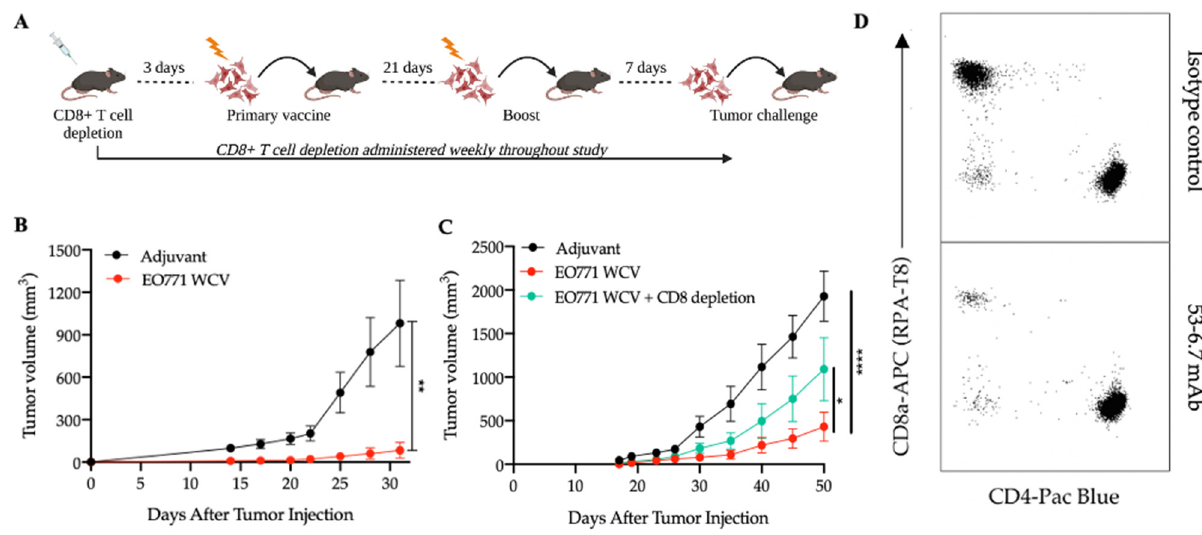
Figure 1. CD8 + T cells are required for protection against mesenchymal-like EO771 tumor growth using EO771 whole cell vaccine (WCV). ( A ) Overview of tumor studies is shown. ( B ) Tumor growth curve of EO771 cells in mice treated with adjuvant alone ( n = 10) or EO771 WCV ( n = 10). Error bars depict mean with SEM. A two-way ANOVA was performed, and significant protection was provided by the EO771 WCV ( p = 0.0052). This experiment represents 4 tumor studies. ( C ) Tumor growth curve of EO771 cells in mice treated with adjuvant ( n = 16), EO771 WCV ( n = 16) or EO771 WCV plus 53-6.7 mAb ( n = 16). Graph represents 2 independent experiments; error bars depict mean with SEM. A two-way ANOVA was performed using Dunnett’s multiple comparisons test. At day 50, there was significant protection against tumor growth in mice treated with EO771 WCV ( p < 0.0001), which was partly reversed in mice that were also CD8-deficient ( p = 0.0157). ( D ) Representative plots from flow cytometric analysis depicting CD8 + T cell depletion from the peripheral blood of mice treated with CD8 + T cell depleting mAb (clone 53-6.7) or isotype control mAb (clone 2A3).